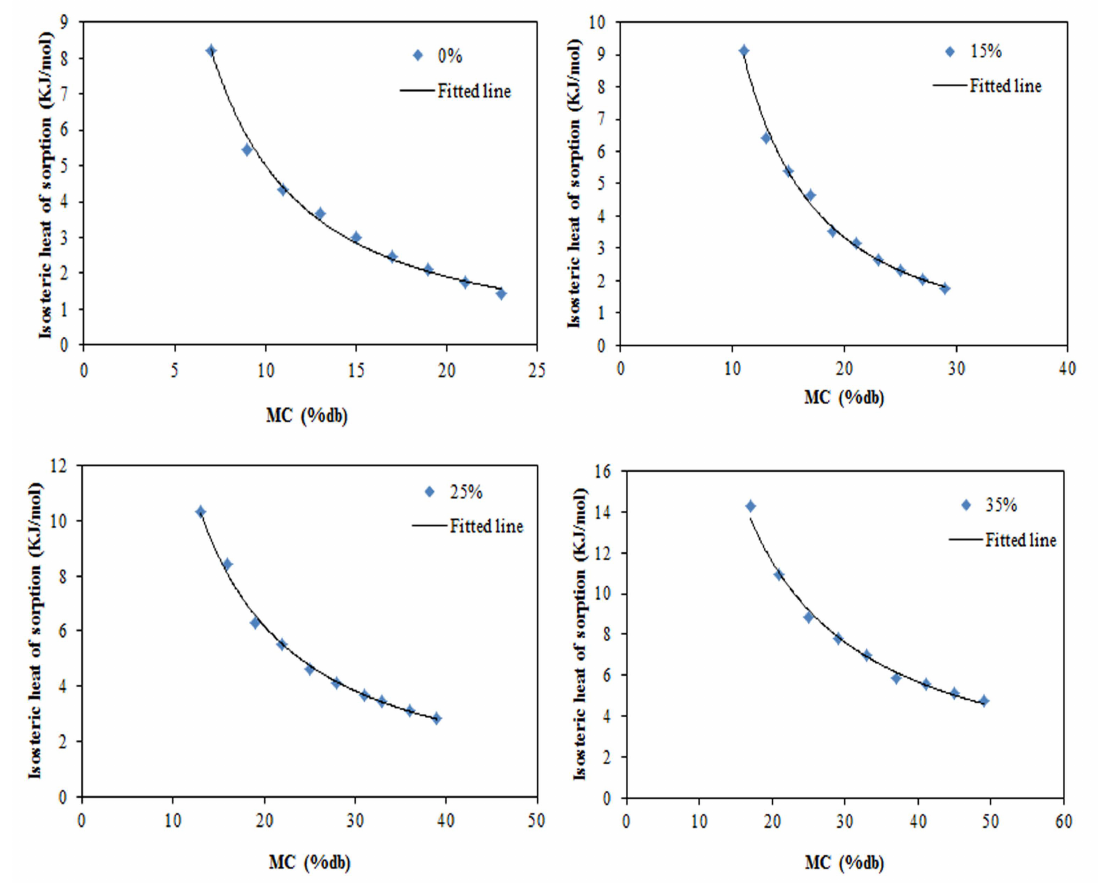
Figure 5. Net isosteric heat of sorption of pea starch films as a function of MC: 0% is pea starch film, 15% is pea starch film content 15% w / w glycerol, 25% is pea starch film content 25% w / w glycerol, and 35% is pea starch film content 35% w / w